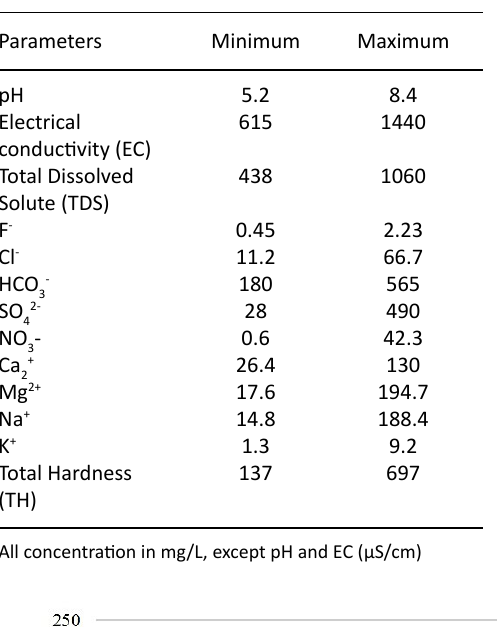
Table 2. Summary of measured parameters in collected water samples